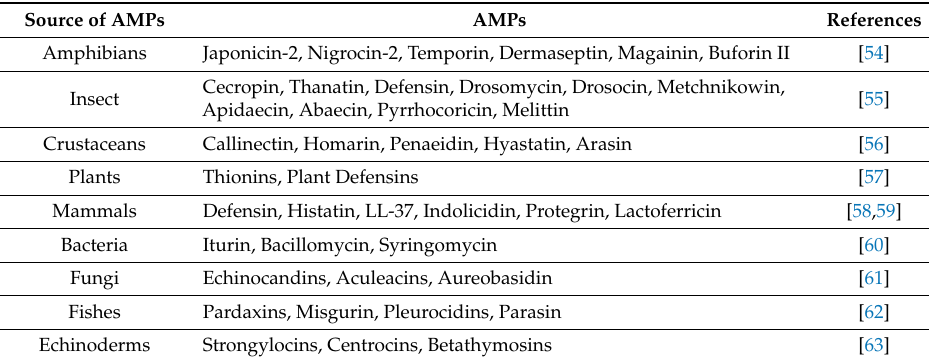
Table 1. AMPs and their